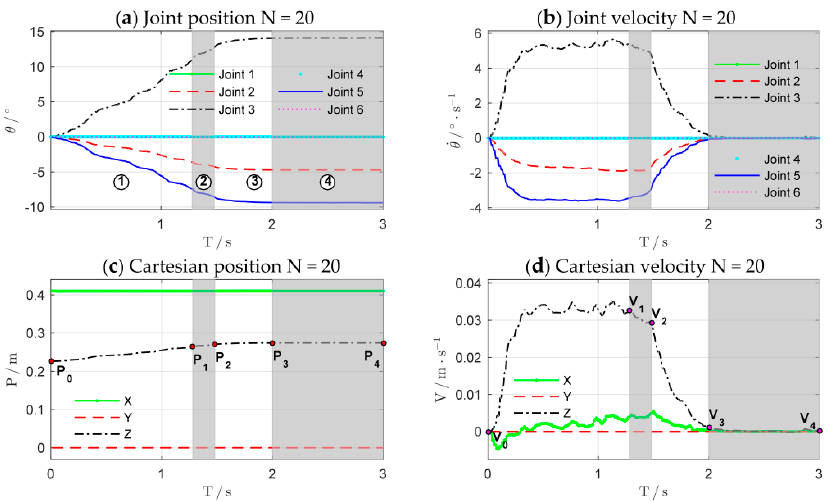
Figure 18. Trajectories during the 20th experiment iteration. ( a ) Joint position; ( b ) Joint velocity; ( c ) Cartesian position of the end-effector; ( d ) Cartesian velocity of the end-effector. Table 1. Key states of the four phases during the 20th iteration